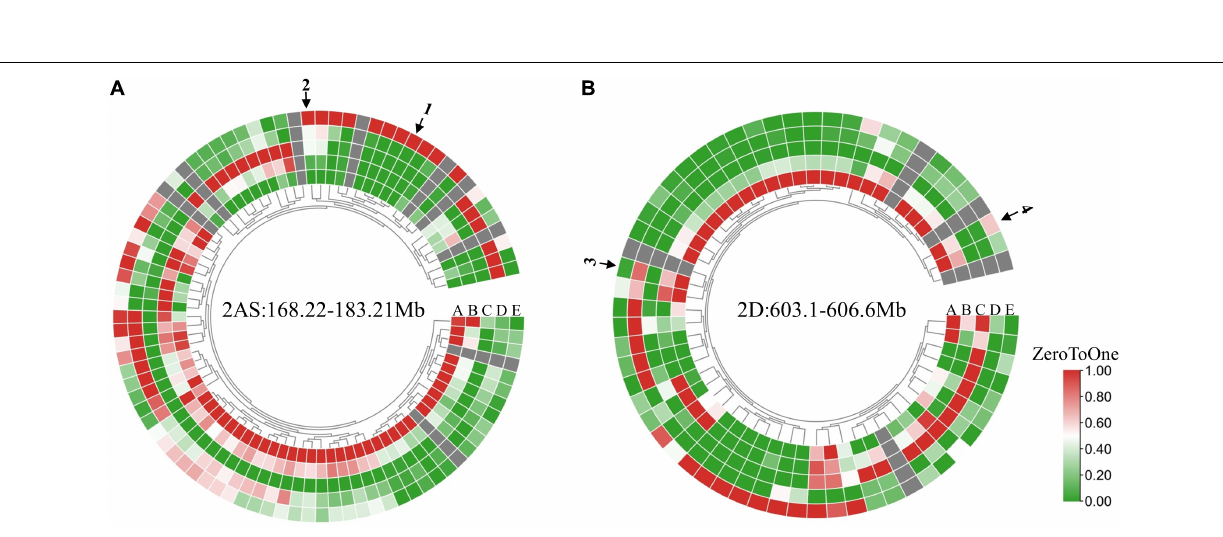
FIGURE 8 | Expression pattern of genes within the QSc/Sl.cib-2AS (A) and QSc/Sl.cib-2D (B) intervals. Expression data originated from the WheatOmics GeneExpression (http://202.194.139.32/expression/index.html). The arrows 1, 2, 3, and 4 represent the predicted candidate genes TraesCS2A03G0410600 , TraesCS2A03G0422300 , TraesCS2D03G1129300 , and TraesCS2D03G1131500 . A, B, C, D, and E (A,B) represent root, stem, leaf, grain, and spike,